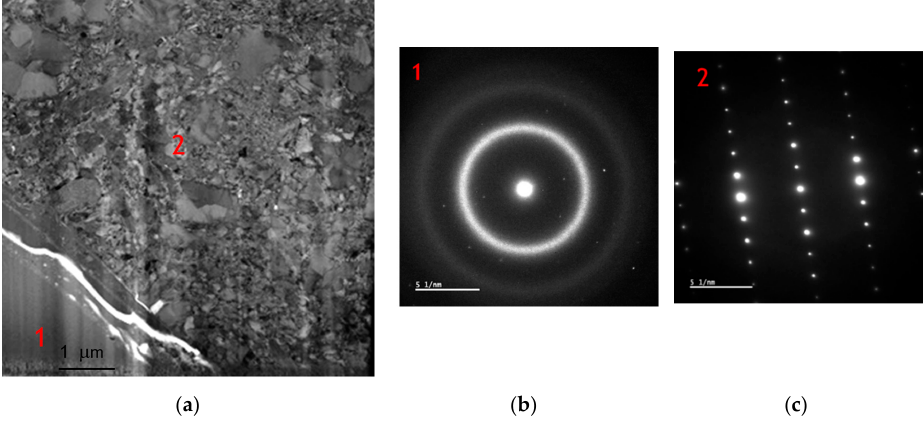
Figure 5. TEM image ( a ) and SAD patterns ( b , c ) of a CGS coating: 1. amorphous region; 2. crystallized region.